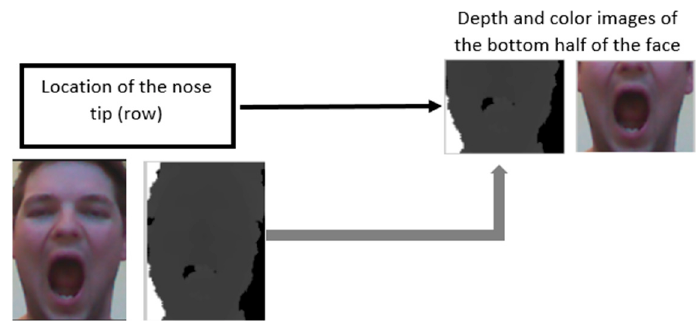
Figure 2. Block diagram of the nose tip detection [9].